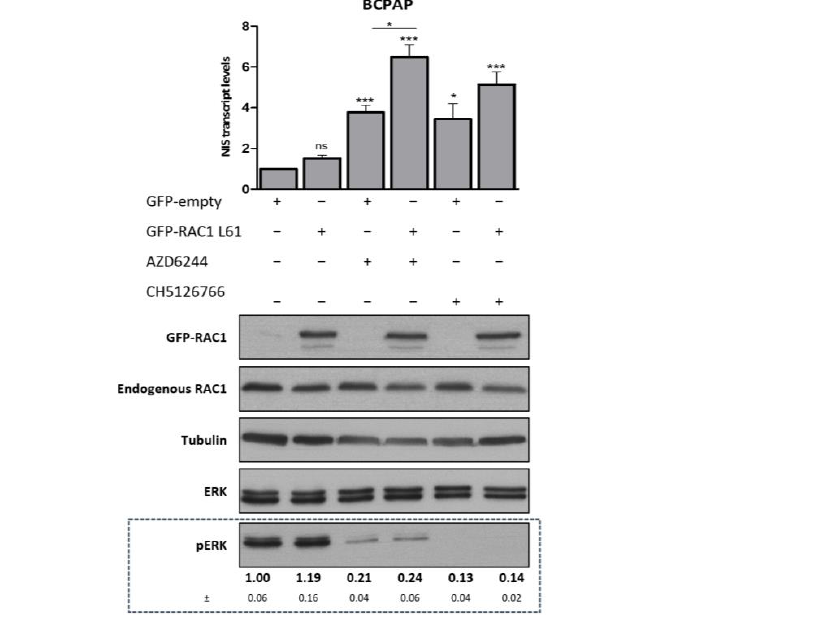
Figure 4. Effect of RAC1 activity on NIS transcriptional rescue by MEK inhibitors in a BRAF-mutant follicular thyroid cancer-derived cell line. The PTC-derived BCPAP cell line was transiently transfected with GFP-empty vector or GFP-RAC1 L61 expressing constructs in the presence or absence of either AZD6244 (10 µ M for 48 h) or CH5126766 (10 µ M for 48 h). NIS mRNA levels